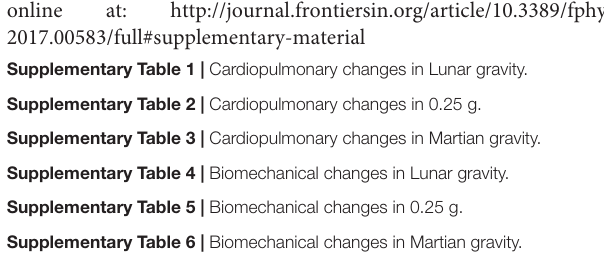
Supplementary Table 1 | Cardiopulmonary changes in Lunar gravity. Supplementary Table 2 | Cardiopulmonary changes in 0.25 g. Supplementary Table 3 | Cardiopulmonary changes in Martian gravity. Supplementary Table 4 | Biomechanical changes in Lunar gravity. Supplementary Table 5 | Biomechanical changes in 0.25 g. Supplementary Table 6 | Biomechanical changes in Martian